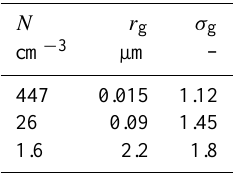
Table 1. Parameters for three lognormal modes of initial aerosol size distribution. For each mode, N is total number concentration, r g mean geometric radius, and σ g mean geometric standard devia- tion.